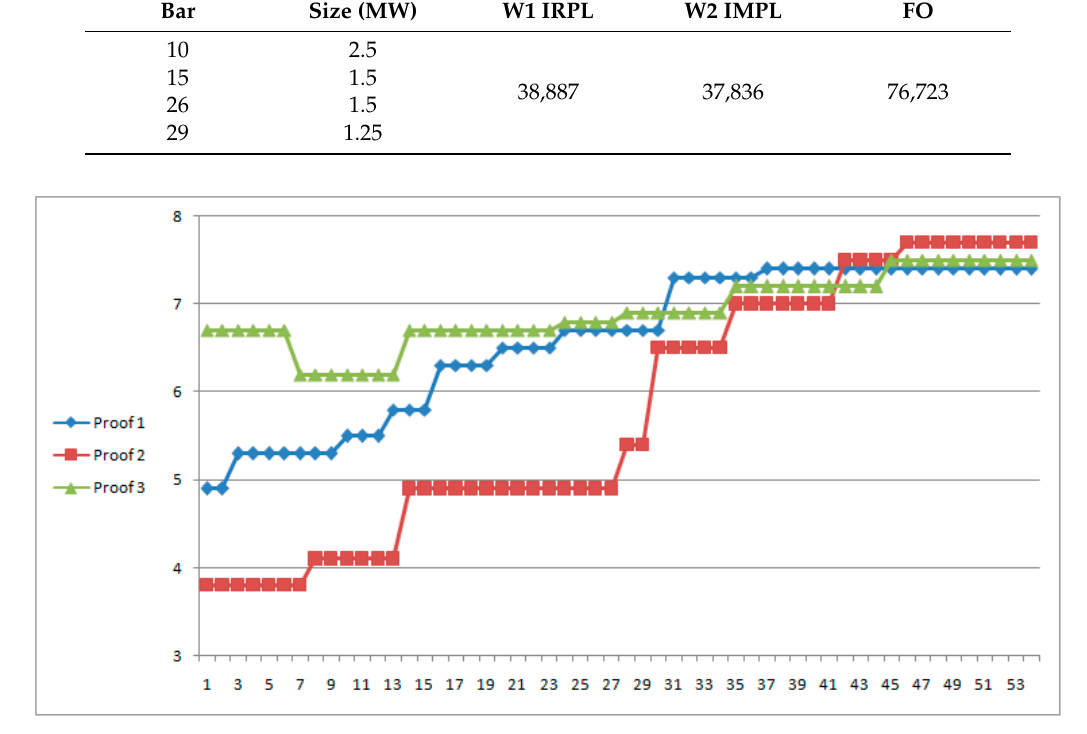
Figure 7. Process of convergence for 3 different GA tests.